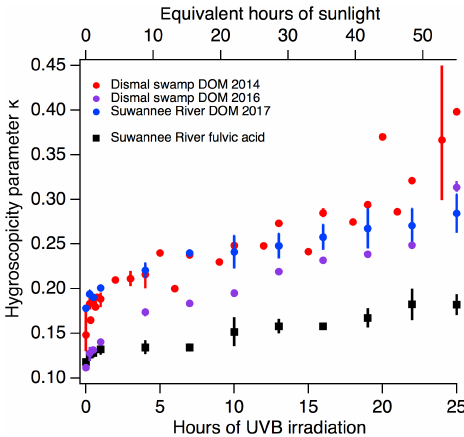
Figure 1. The CCN ability of DOM and of Suwannee River fulvic acid (SRFA) increases as a function of irradiation. The experimen- tal conditions are equivalent to up to 25h of UVB exposure ( ∼ 55h of sunlight in the atmosphere). The colours indicate different source material (DS 2014 in red, DS 2016 in purple, SR 2017 in blue and SRFA in black), and the symbols indicate the material was field- collected (circles) or commercially available (squares). The instru- mental uncertainty in κ = ± 0 . 01. To show the spread of the mea- surements, the variance from multiple independent experiments are illustrated as bars. The variance was used since not every point had triplicates for standard deviations to be